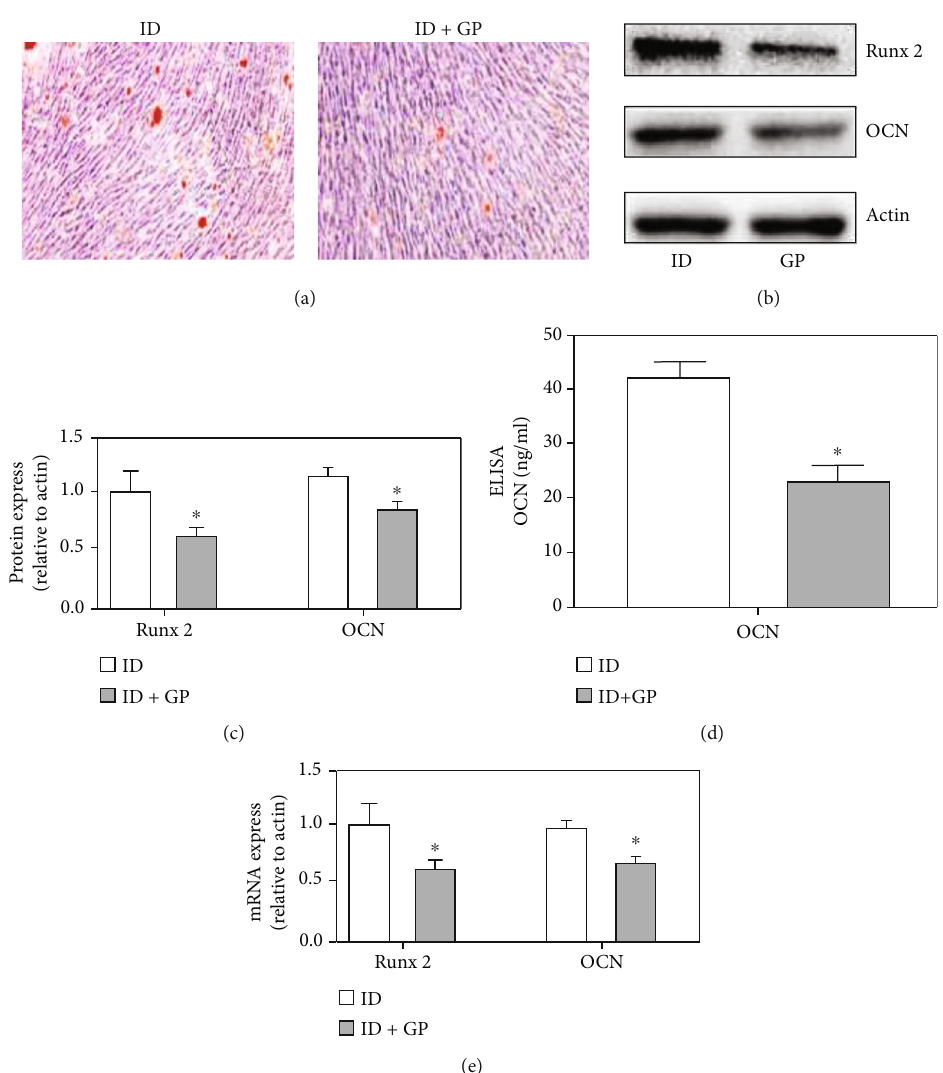
Figure 2: High glucose and high fat inhibited the di ff erentiation of osteoblast precursors. (a) Mineralization was analyzed through alizarin red staining. (b) The protein expression of Runx2 and OCN was measured through western blotting after treatment with ID or ID+GP; (c) The protein expression of Runx2 and OCN was analyzed. (d) The level of OCN was measured with ELISA. (e) The mRNA expression of Runx2 and OCN was detected. Compared with the ID group, ∗ P < 0 : 05 . MC3T3-E1 was used in these